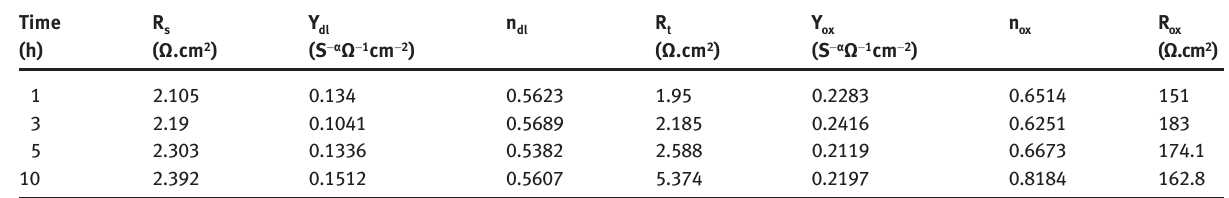
Table 2: Fitting results of the impedance spectra for porous Cu-35mass%Ni-10mass%Cr in molten (0.62Li,0.38K) 2 CO 3 at 650 °C in air